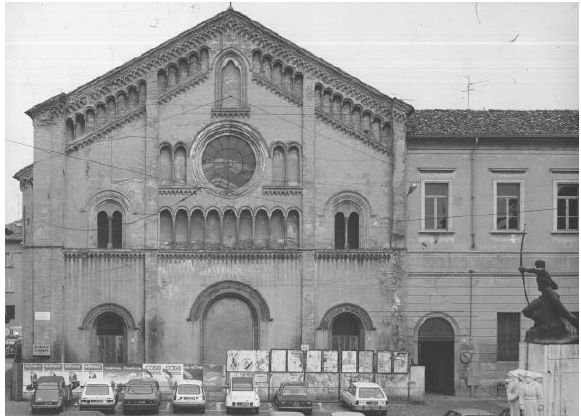
Figure 1: Church of San Domenico in Crema (Cr) 1984. The rectified image has been taken directly photographically with a reflex camera with a tilt-shift lens and later plotted at 1:50 scale. (Degree Thesis, Campanella Zucchetti) A production that assumed proportions of real “professional activity” at the beginning of 1860, when new physical